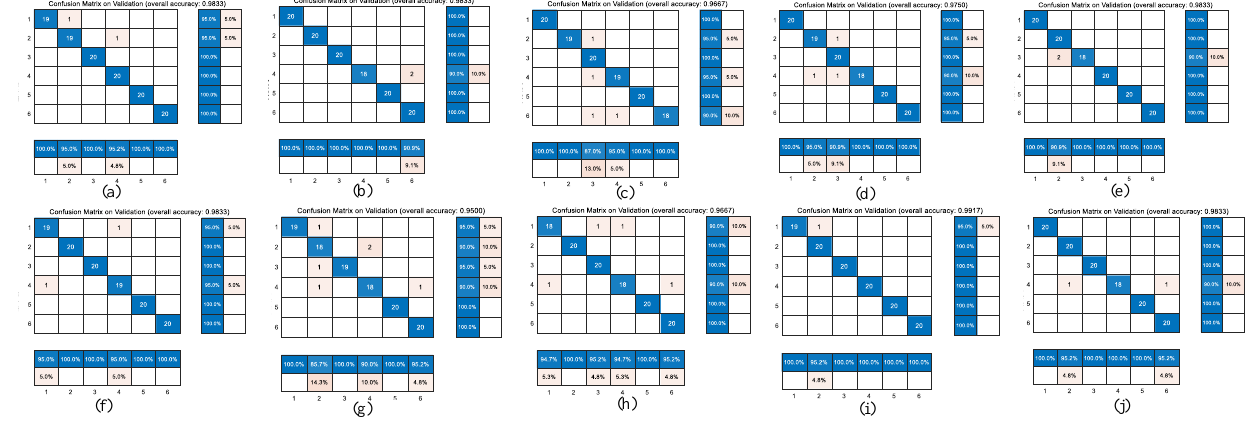
Figure 7. 10-fold cross validation of confusion matrix for the GoogleNet model on original heart sound database. The accuracy of each fold is: ( a ): 0.98; ( b ): 0.98; ( c ): 0.97; ( d ): 0.98; ( e ): 0.98; ( f ): 0.98; ( g ): 0.95; ( h ): 0.97; ( i ): 0.99; ( j ): 0.98. Table 6. Results for multiple class classification on GoogleNet.